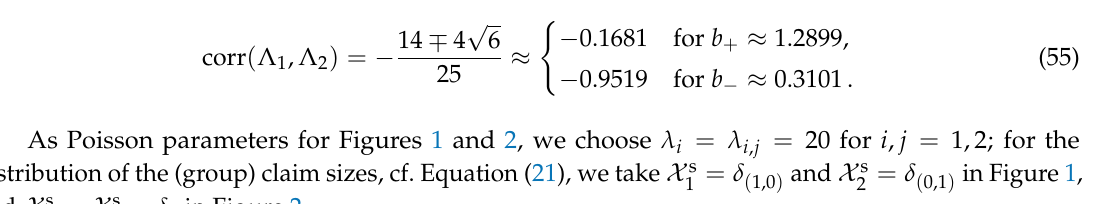
Λ = Λ ≡ 1, yielding a Poisson 2 1